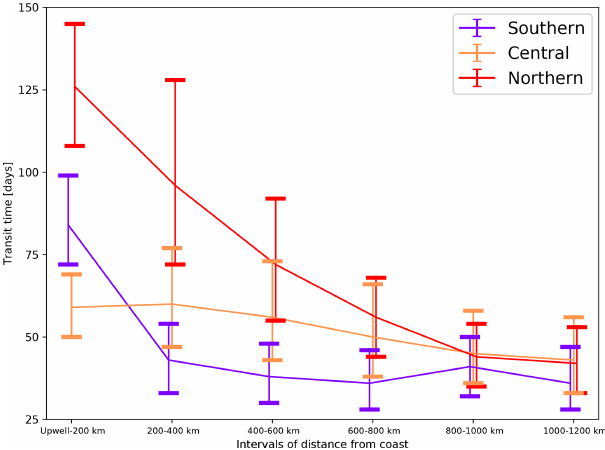
Figure 3. A plot of median transit times for particles to traverse subsequent intervals of distance from the coast for the three sub- regions in the CanCS. The first point shows the transit time from particles’ upwelling to distances reaching 200km. The error bars indicate the 10 percentile distributions above and below the median transit times. Only particles that traverse the whole distance range are